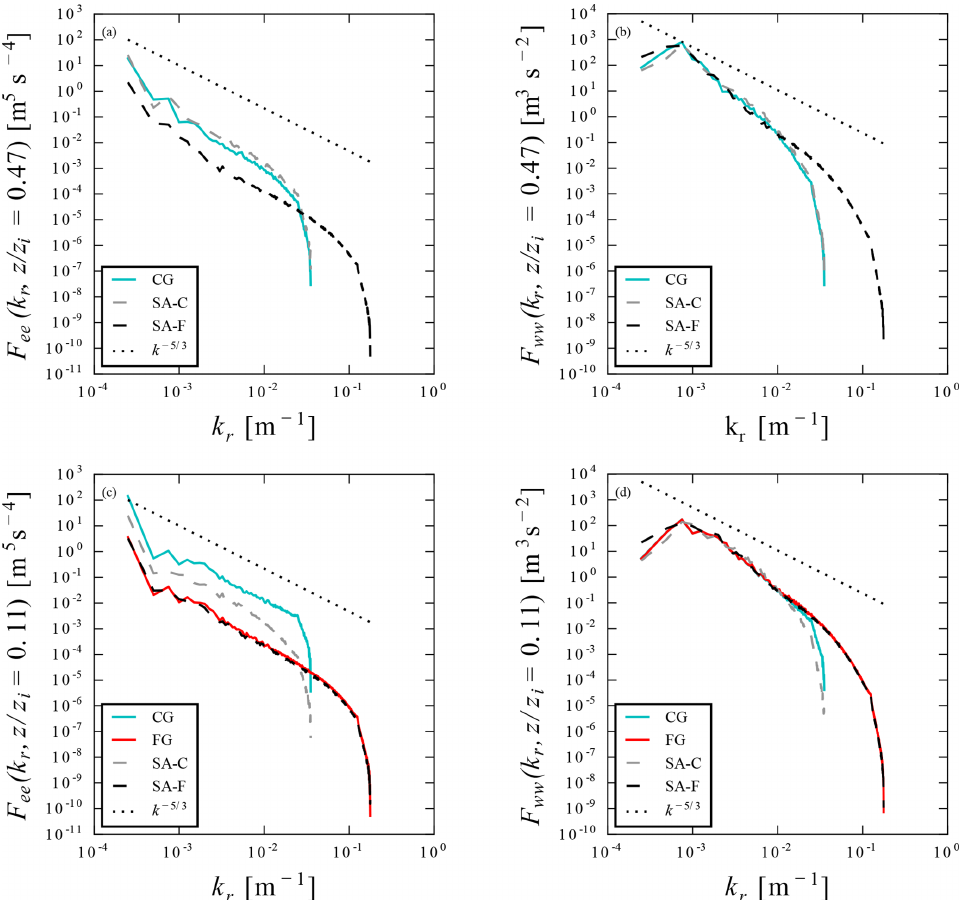
Figure 9. Spectra of SGS turbulent kinetic energy ( e ) (a, c) and vertical velocity ( w ) (b, d) . At z/z i = 0 . 47 (a, b) and at z/z i = 0 . 11 (c, d) , k r is the horizontal